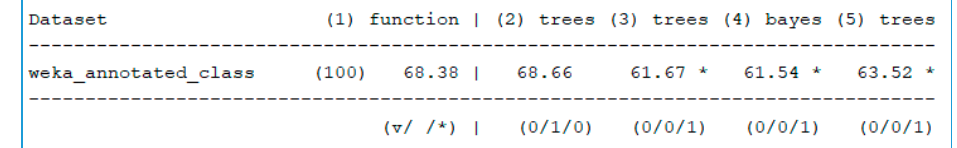
Figure 12. T-test results (1-SVM, 2-RF, 3-DT, 4-BN, 5-LMT).